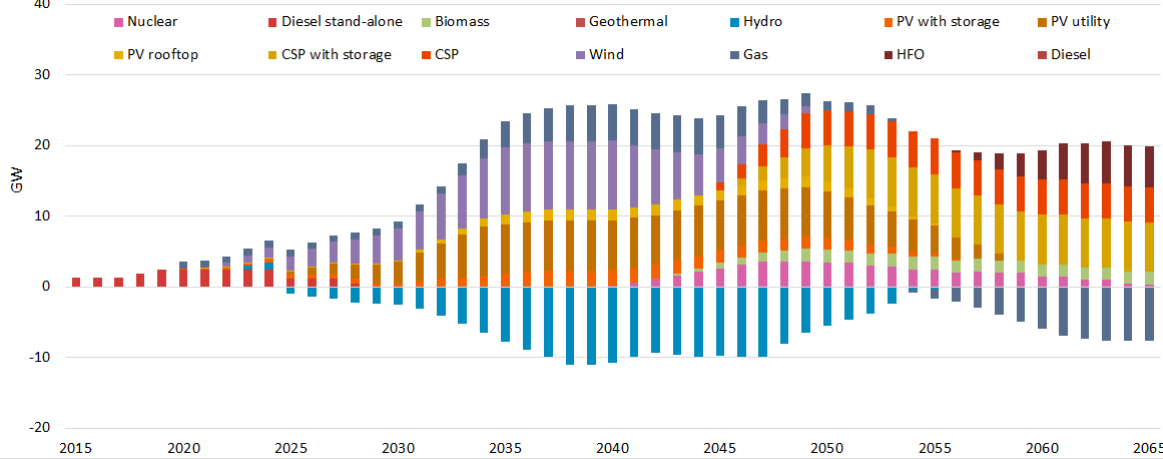
Figure 2. Comparison of power generation capacity between Drought vs. New Policy Scenarios. Table 2. Comparison of Power Generation Capacity of Drought and New Policy